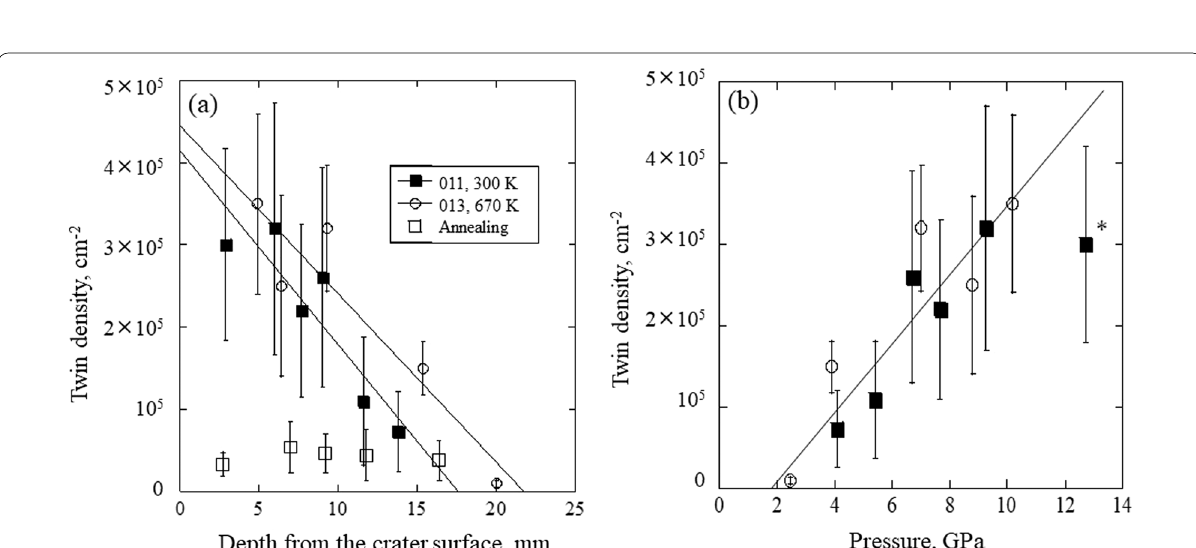
Fig. 12 a The twin density from the top to the bottom of the samples recovered from the impacts at room temperature (Solid squares, Run 011) and 670 K (Open circles, Run 013). The density after annealing at 1070 K (Open squares, Run011H) for 10 min is also shown. The twin distribution is expressed as a linear relation, N (cm − 2 ) 4.14 10 5 –2.34 10 4 D (mm) ( R 0.908) for the room temperature impact, and N (cm − 2 ) = × × × = 2.05 10 4 D (mm) ( R 0.936) for the impact at 670 K, where N is the density of twins in a unit area of 1 cm 2 , and D is the depth of the sample × × = from the crater surface in mm. ( b ) The relation between the twin density and pressure (GPa) that was deduced by the iSALE-2D simulation. The relation can be expressed by N (cm − 2 ) –6.30 10 4 4.11 10 4 P (GPa) ( R 0.905). All data for room temperature (solid squares) and = × + × × = 670 K (open circles) are included for the fitting except a data point (*) at 13 GPa in which the twin density close to the crater may be reduced by increasing pressure and